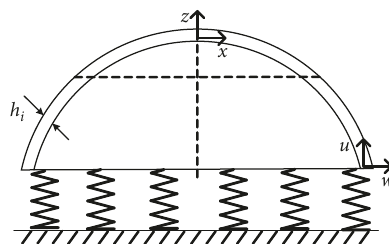
Figure 3: Spherical cap with elastic boundary restraints.